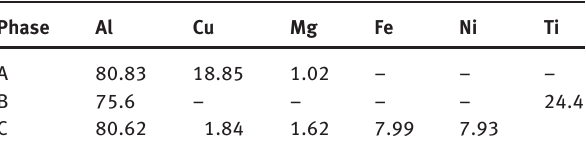
Table 2: Chemical compositions of intermetallic phases existed in Ti-containing alloy 2618 (at.%) Phase